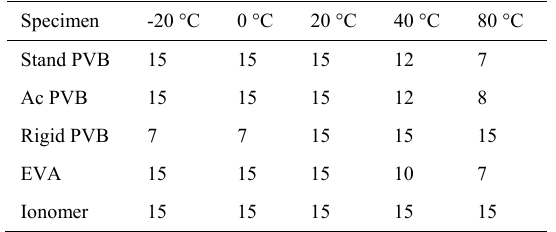
Table 2: Amount of impacted samples per temperature for MBH determination